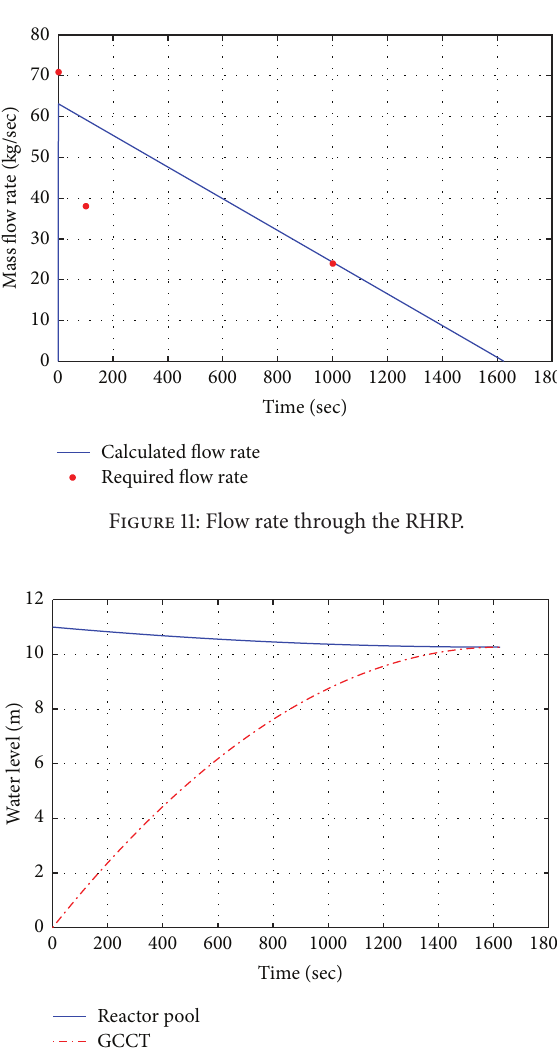
Figure 12: Water levels of reactor pool and